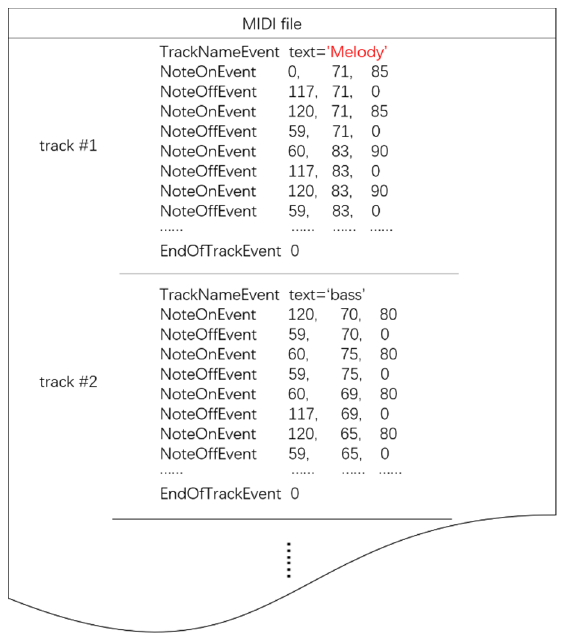
Figure 6. Information extracted from a musical instrument digital interface (MIDI) file.